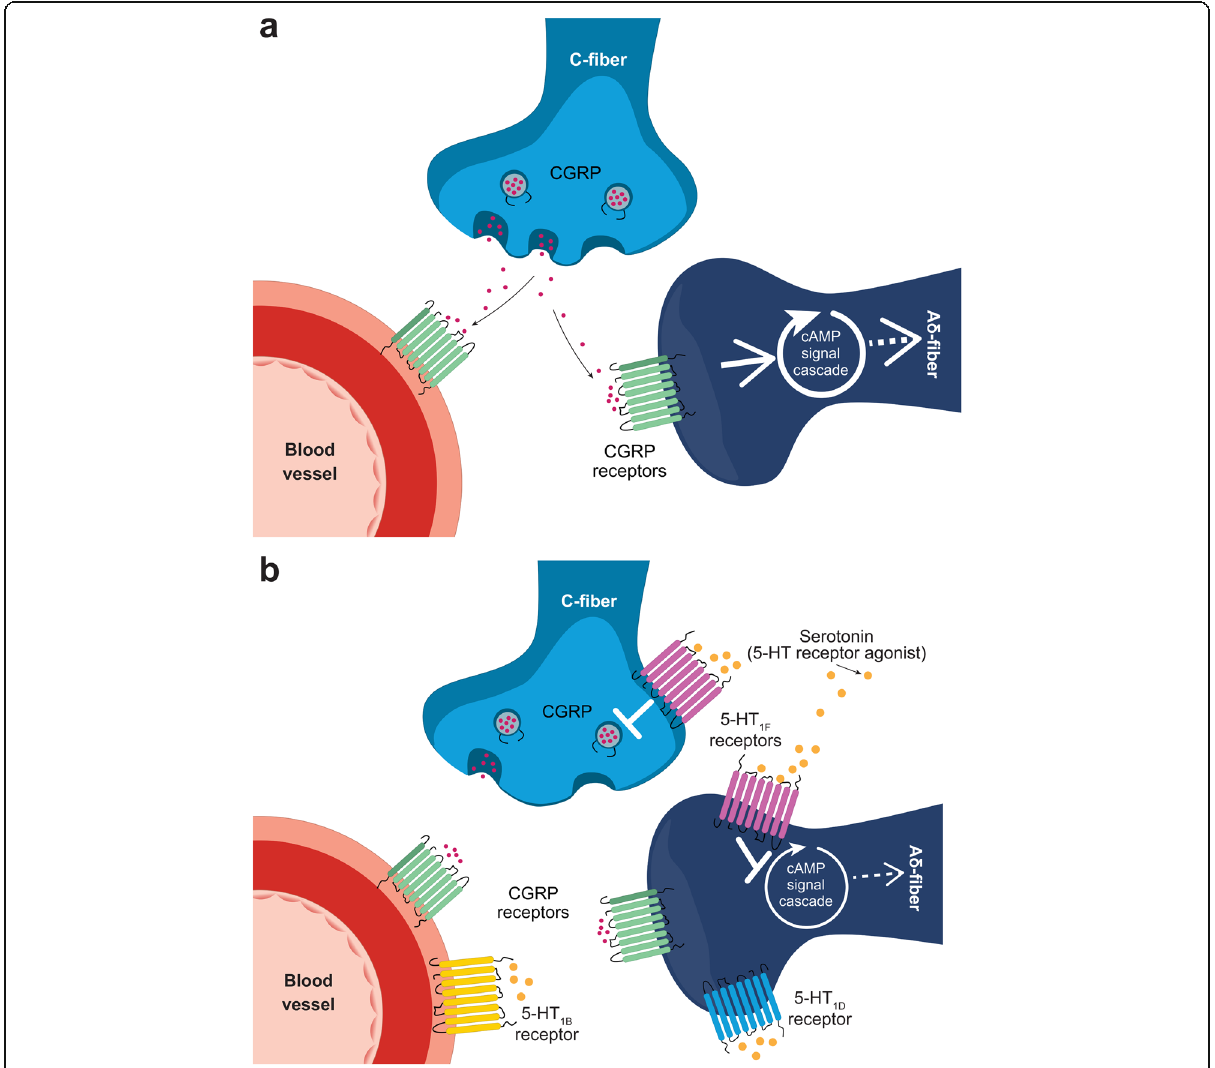
Fig. 2 a Neuropeptides and neurotransmitters regulate pain during a migraine attack. Nerve activity in the trigeminovascular pain pathway leads to the release of neuropeptides and neurotransmitters, such as CGRP and glutamate that can hyperexcite neurons, thereby propagating PNS and CNS pain responses. b The thalamic trigeminovascular neurons, trigeminal ganglion, and the trigeminal nucleus caudalis are densely innervated with serotonergic neurons. Subtypes of serotonin (5-HT) receptors found in these areas, such as 5-HT1F, are believed to be involved in the pathophysiology of migraine. Serotonin receptor agonists are the foundation of many acute treatments for migraine; however, many of these therapeutics are associated with vasoconstriction through activation of 5-HT1B receptors. Serotonin binding to 5-HT1F receptors can inhibit presynaptic vesicular release of CGRP and inhibit postsynaptic cAMP signaling cascades. Abbreviations: 5-HT, 5-hydroxytryptamine (serotonin); 5- HT1, 5-hydroxytryptamine 1 receptor; cAMP, cyclic adenosine monophosphate; CGRP, calcitonin gene-related peptide; CNS, central nervous system; PNS, peripheral nervous